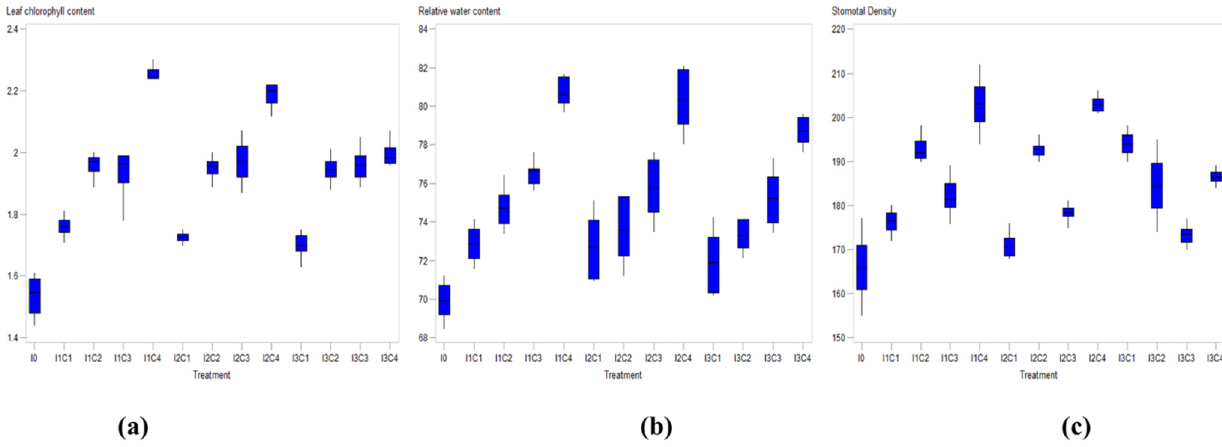
Figure 6. Influence of different irrigation levels at various crop phenological stages on ( a ) leaf chlorophyll content, ( b ) relative water content, and ( c ) stomatal density.